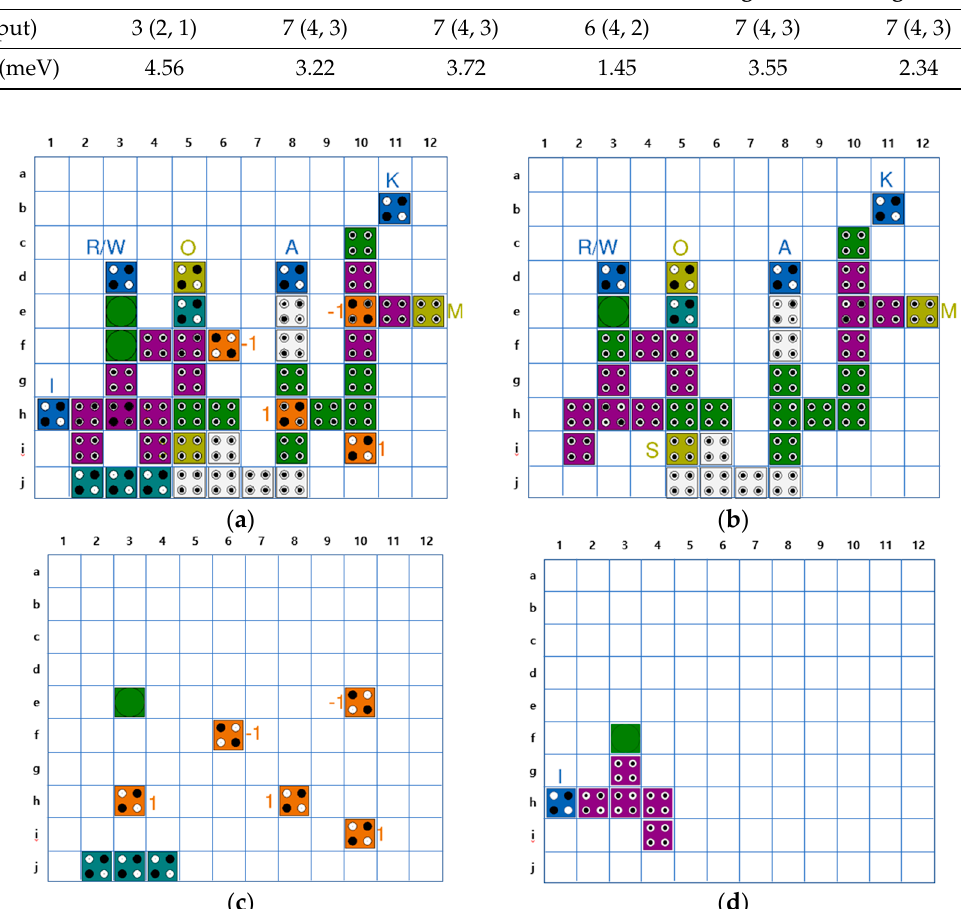
Figure 16. Energy Optimized QCA CAM cell: ( a ) All layer; ( b ) Layer 1; ( c ) Layer 2; ( d ) Layer